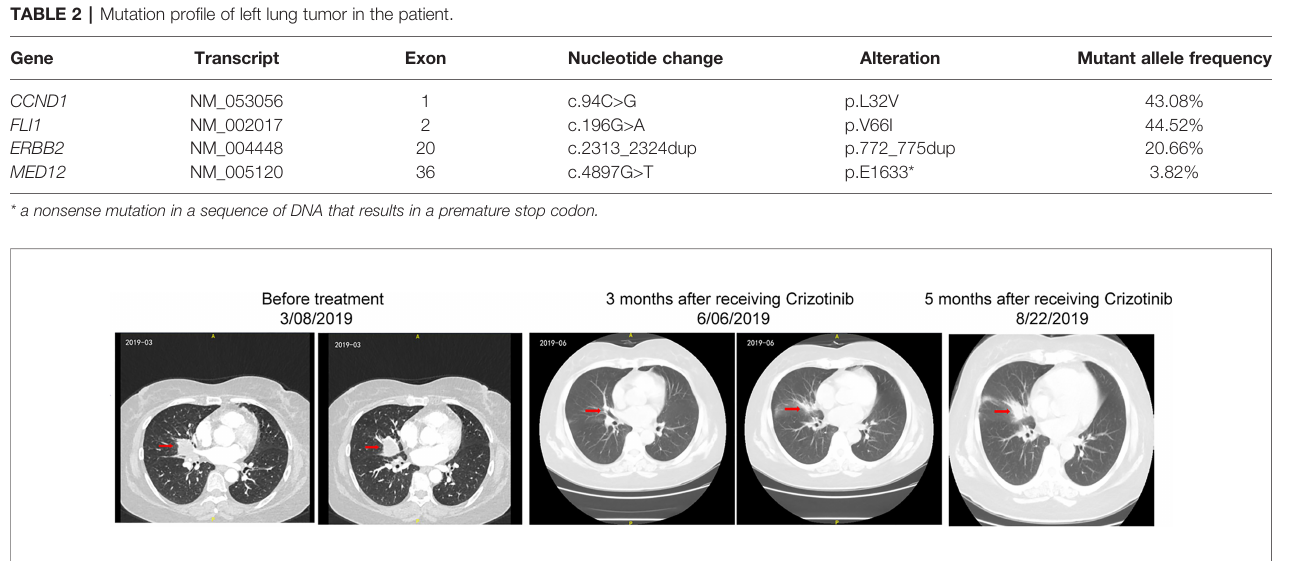
FIGURE 3 | Dynamic imaging of the soft tissue density nodule in the right middle lobe and near the hilum during the treatment with crizotinib.